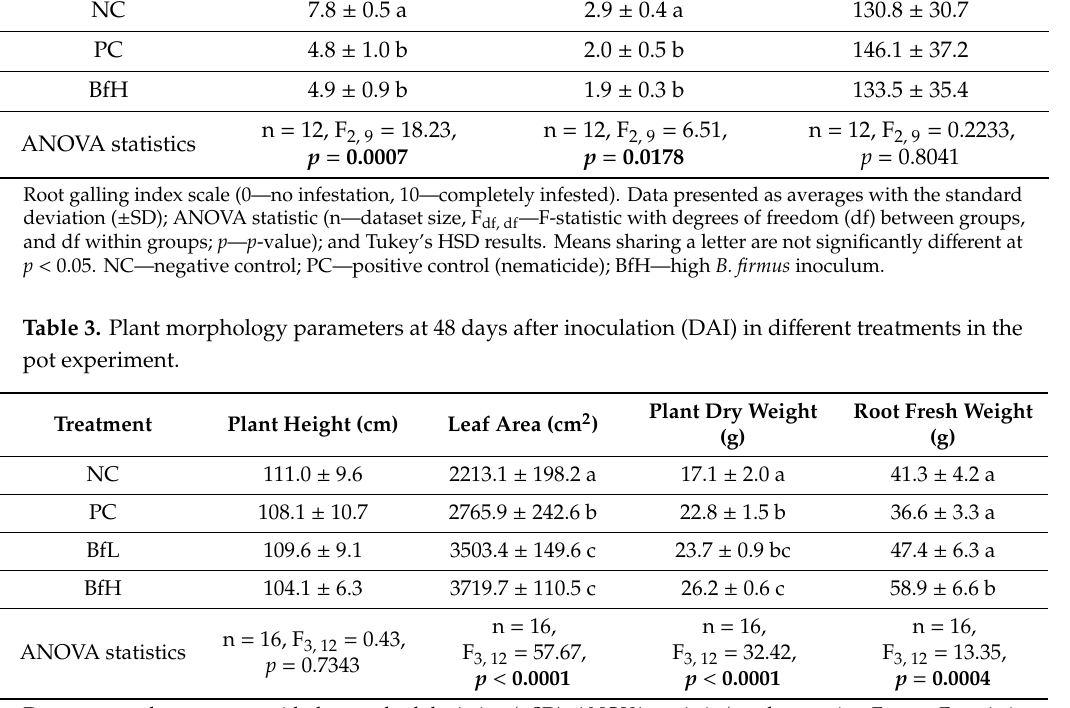
Table 2. Evaluation of Meloidogyne luci infestation in tomatoes in the microplot experiment. Treatment